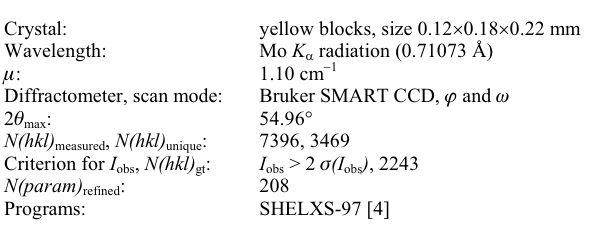
Table 1. Data collection and handling.